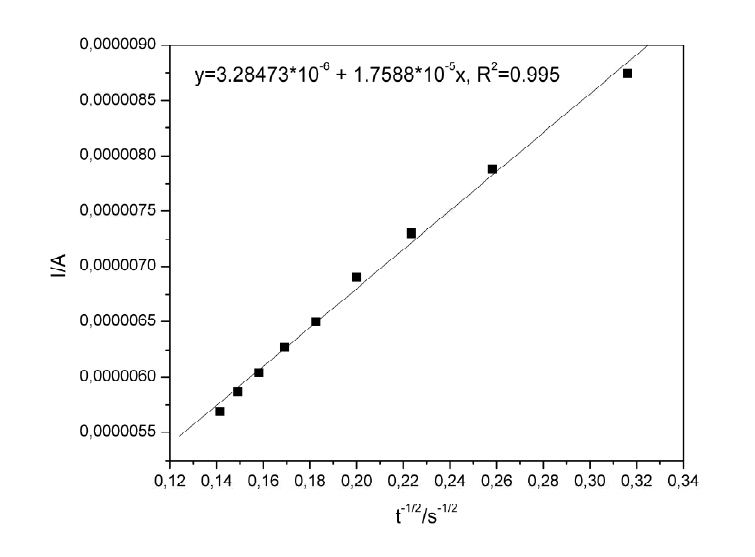
Figure 7. Cottrell’s plot for potential step chronoamperometry of EG-PS in 0.1 M Na